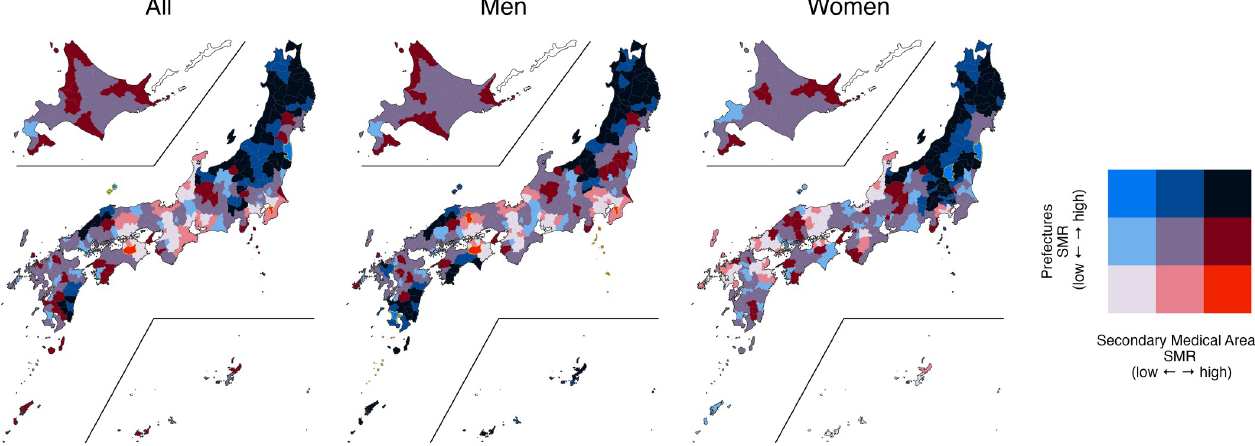
Fig 4. Bivariate map between secondary medical areas and prefectures. SMR: standardized mortality ratio; geographic distribution was visualized based on the tertiles of each region. The following map data (CC BY 4.0) was processed and used: Ministry of Land, Infrastructure, Transport and Tourism. National surveys of Japan—Administrative area data (in Japanese). 2019. Available from: https://nlftp.mlit.go.jp/ksj/gml/datalist/KsjTmplt-N03-v3_0.html.